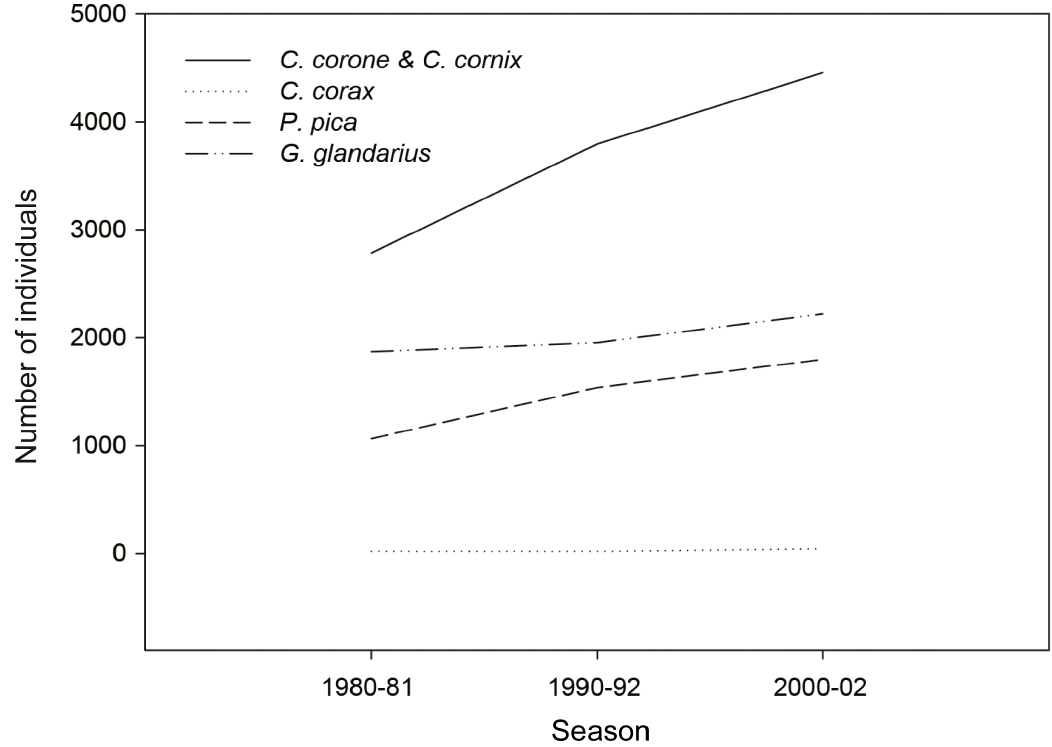
Figure 4. Changes in population sizes of corvid species ( Corvus corone , C. cornix , C. corax , Pica pica , and Garrulus glandarius ). Census results from the years 1980–1981, 1990–1992, and 2000–2002. Graphical representations developed from data of the “Brutvogelatlas” [57]. Data are not necessarily described by linear increase but are presented as lines in order to enhance their visibility.